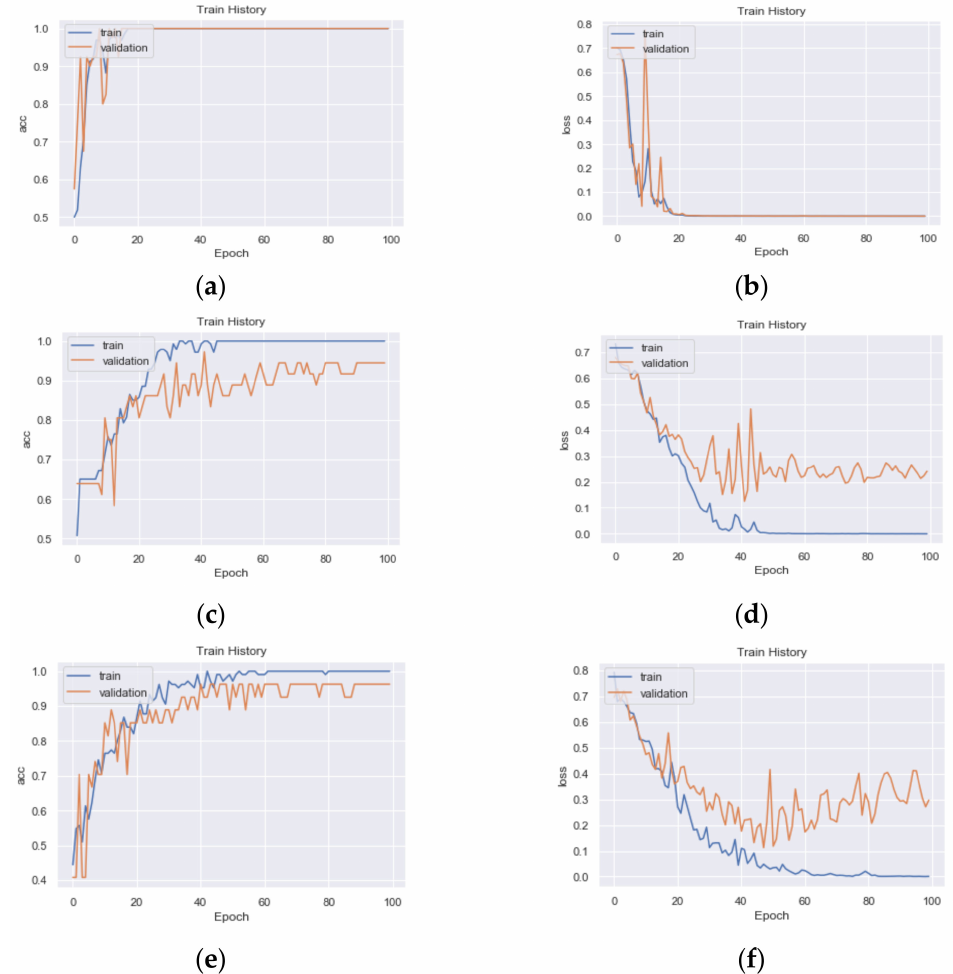
Figure 18. The learning of CNN models for G1, G2, and G3: ( a ) training accuracy vs. validation accuracy for G1; ( b ) training loss vs. validation loss for G1; ( c ) training accuracy vs. validation accuracy for G2; ( d ) training loss vs. validation loss for G2; ( e ) training accuracy vs. validation accuracy for G3; ( f ) training loss vs. validation loss for G3.